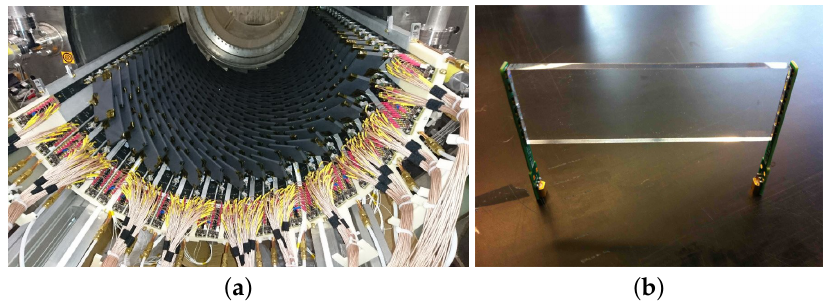
Figure 2. ( a ) Picture of a single pTC module installed inside the COBRA volume. At the time of the picture the CDCH had not been installed yet. ( b ) Picture of a single pTC tile before the installation inside the